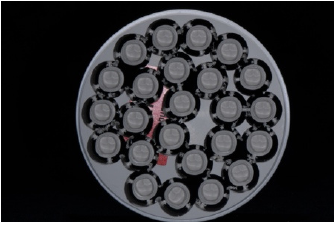
Figure 2. PEEK blank with milled primary crowns of 1° and 2° taper angles.